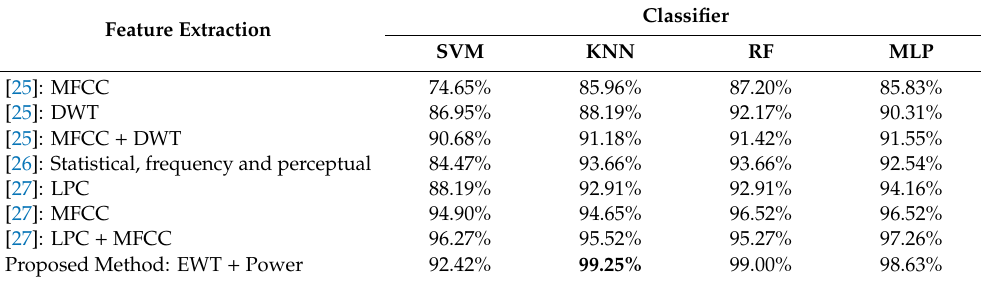
Table 12. Results of accuracy between the methods in [25–27] and the proposed